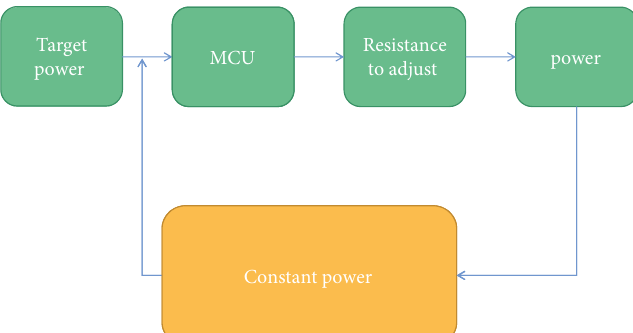
Figure 6: Constant power